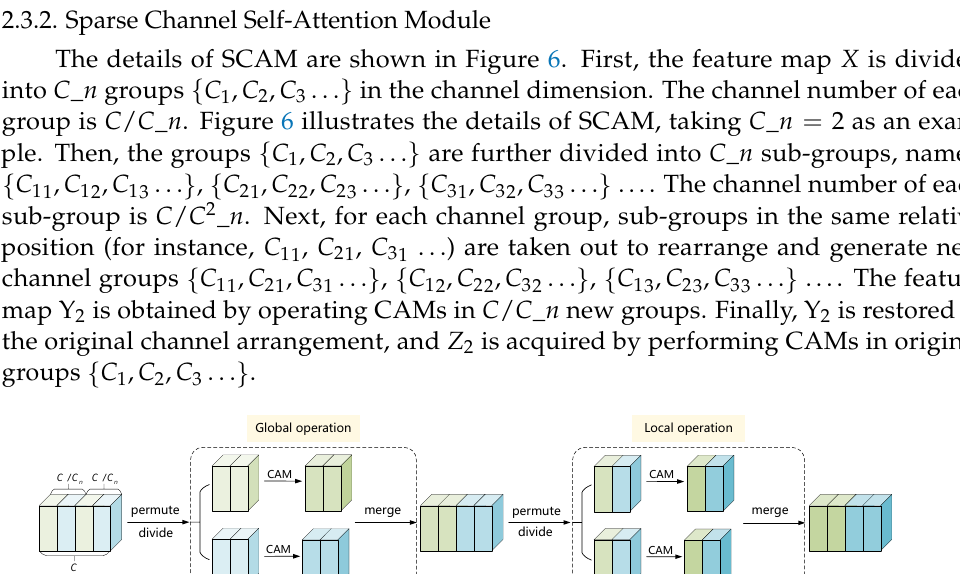
Figure 5. The architecture of the channel self-attention module (CAM).